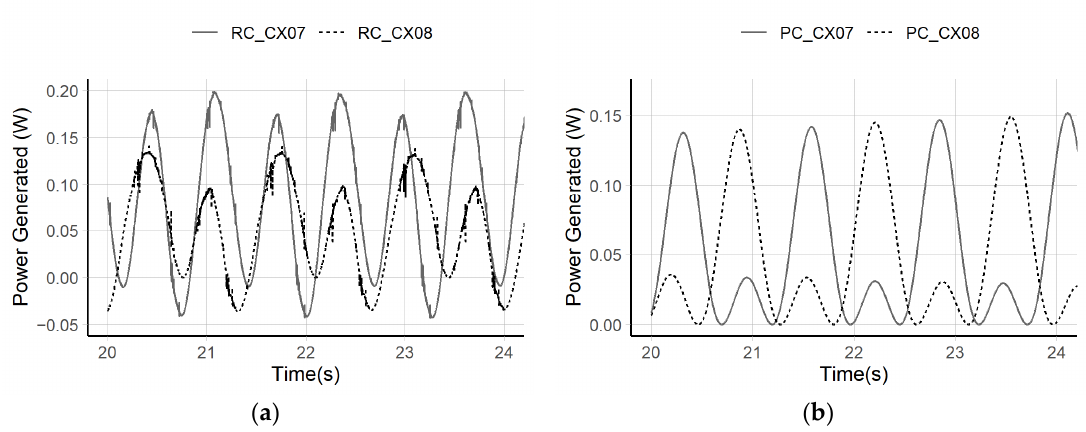
Figure 13. ( a ) Power generated for cases CX07-CX08 using reactive control; ( b ) power generated for cases CX07-CX08 using passive control.